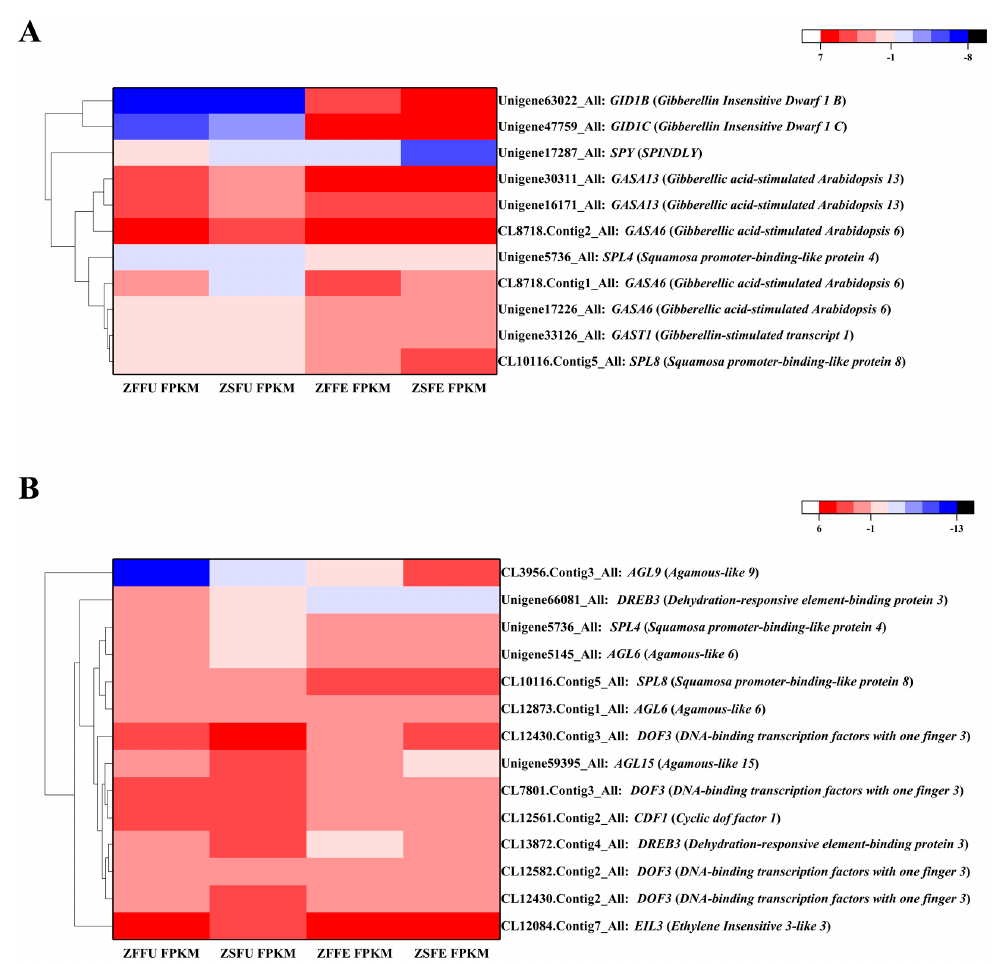
Figure 4. Heatmap of shared DEGs related to flowering. ( A ) The heat map of DEGs putatively associated with gibberellin signaling; ( B ) the heat map of DEGs putatively associated with transcription factors. ZFFU = spring dormant flower buds; ZFFE = spring expanded flower buds; ZSFU = summer dormant flower buds; ZSFE = summer expanded flower